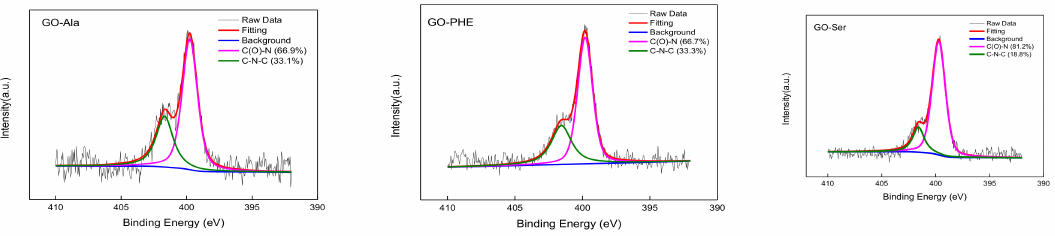
Figure 4. XPS N1s spectra of GO-Ala, GO-PHE, and